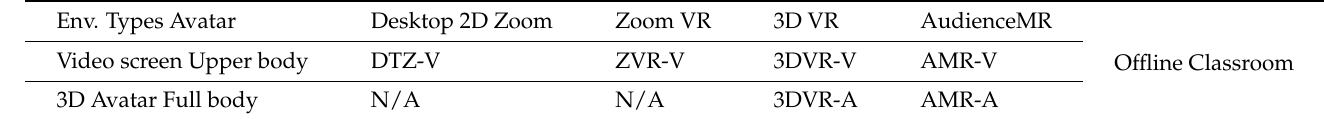
Table 3. Experimental conditions and